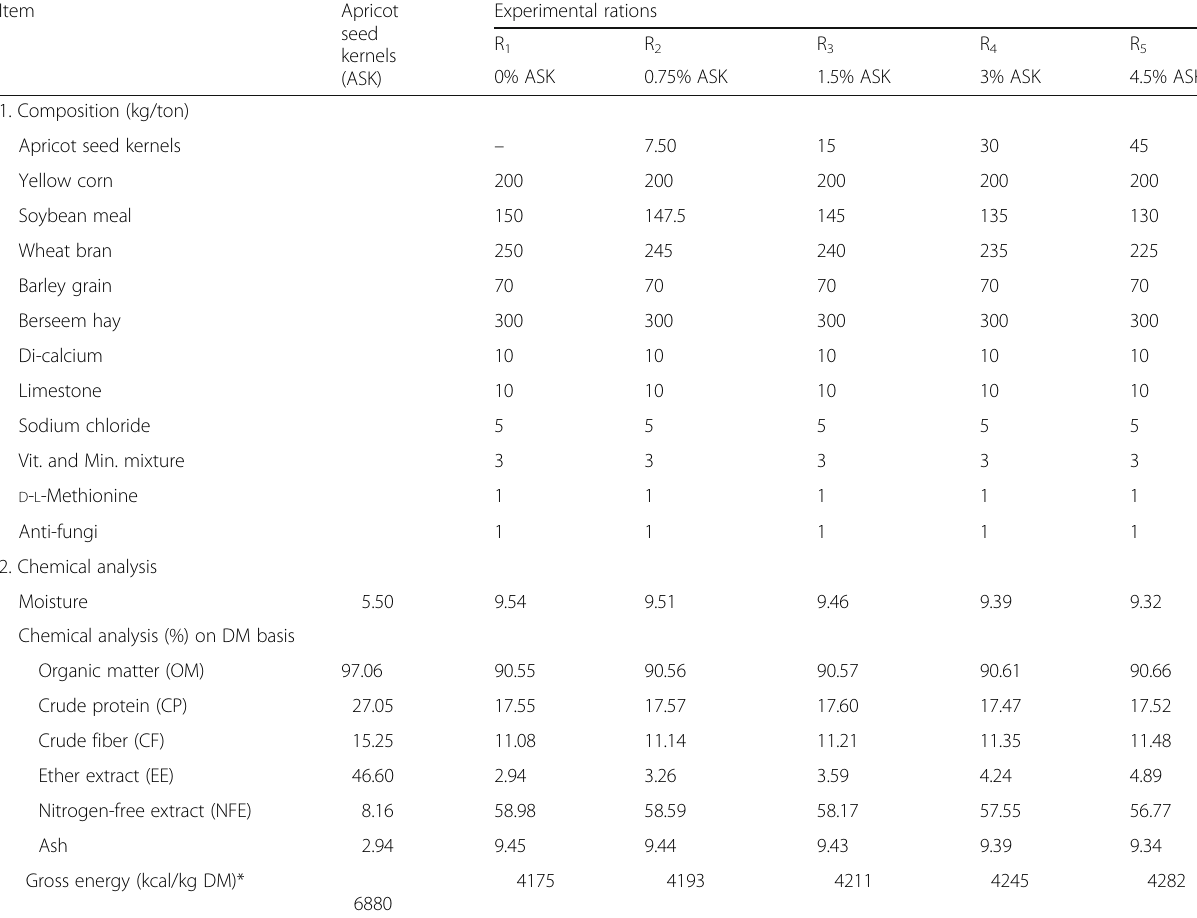
Table 1 Composition and chemical analysis of ASK and experimental rations